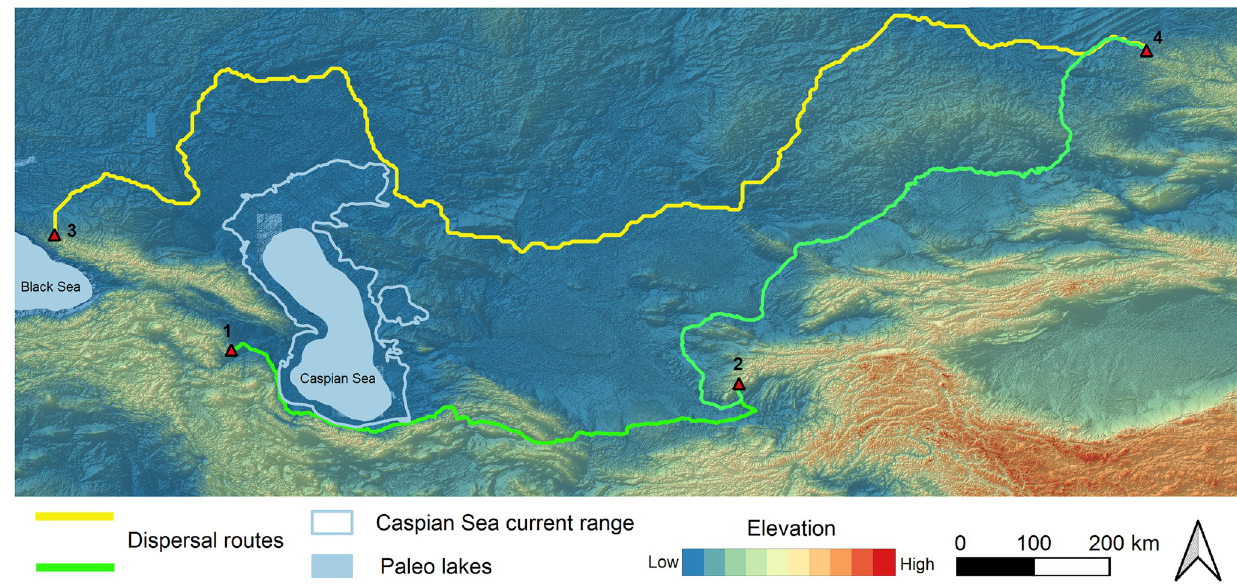
Fig 8. Least-cost-path from Caucasus towards east. 1: Azokh, 2. Teshik-Tash, 3. Mezmaiskaya, 4. Chagyrskaya. The yellow line indicates the Northern Caspian dispersal route and the green line indicates the Southern Caspian dispersal route.